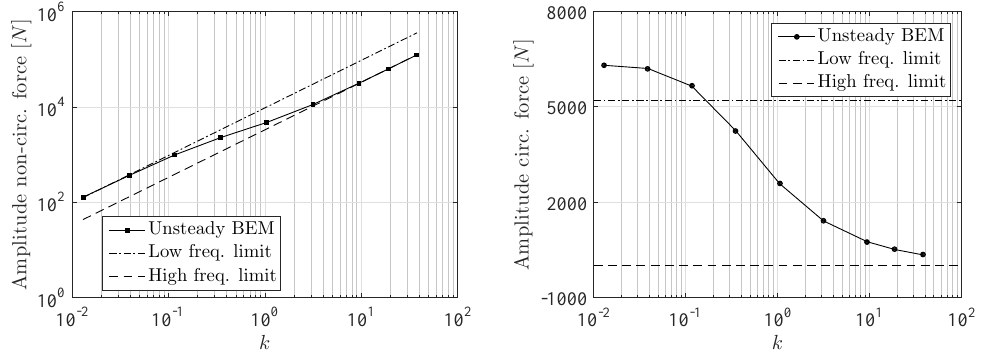
Figure 7. Amplitude of non-circulatory and circulatory forces in plunge direction for different plunge frequencies.